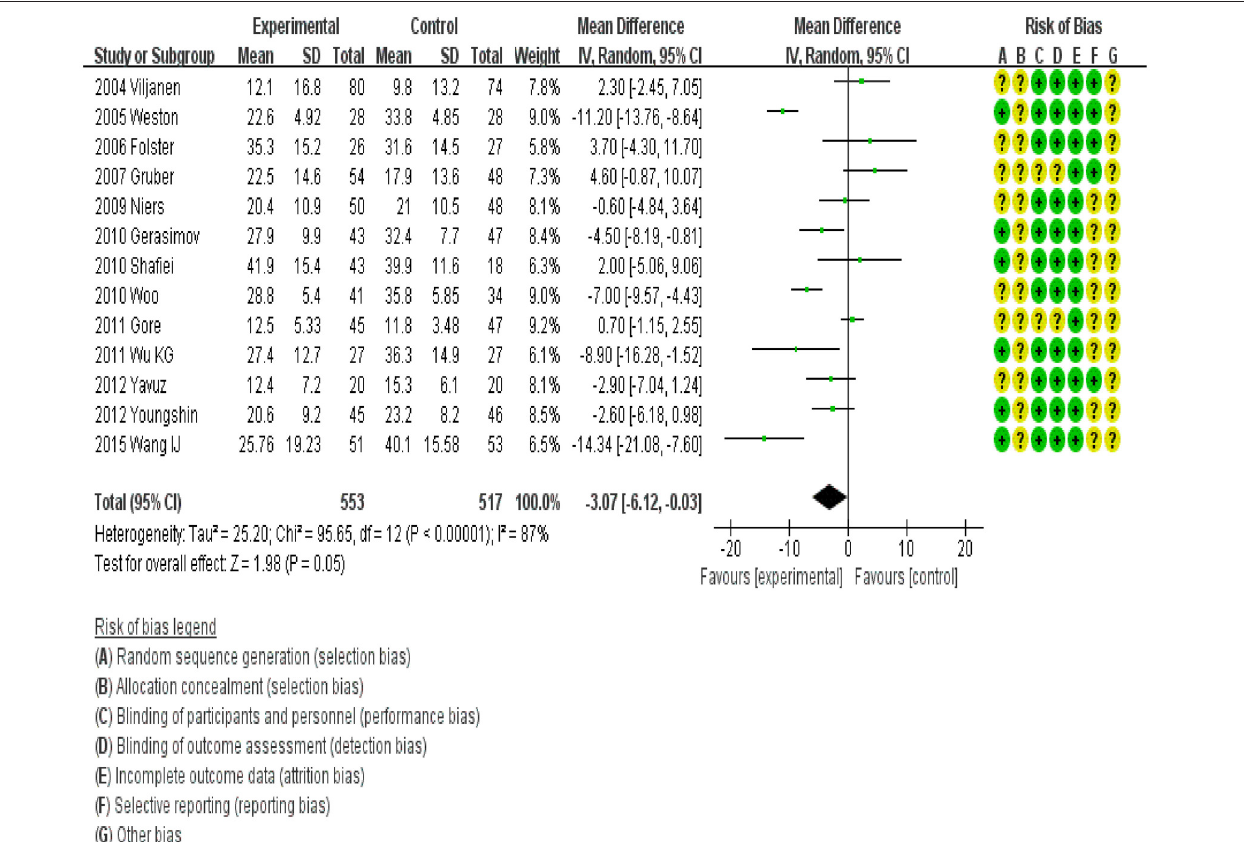
FIGURE 3 | MD scoring with probiotics treatment compared to control and placebo interventions. 95%CI, 95% confidence interval.